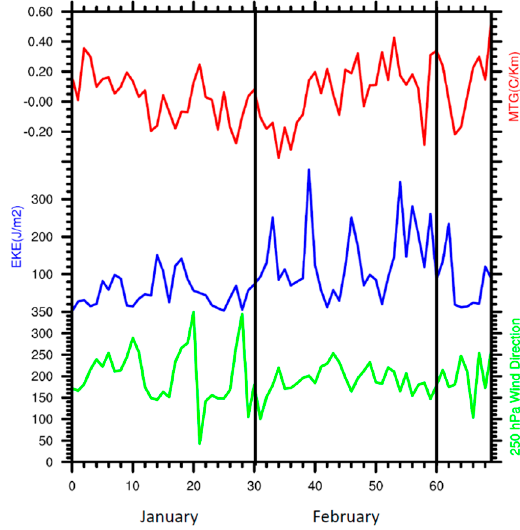
Figure 12. Time series of daily meridional temperature gradient (°C Km − 1 ), Eddy Kinetic Energy (J/m 2 ) and 250 hPa wind direction (in degrees) over the Bering Sea region.